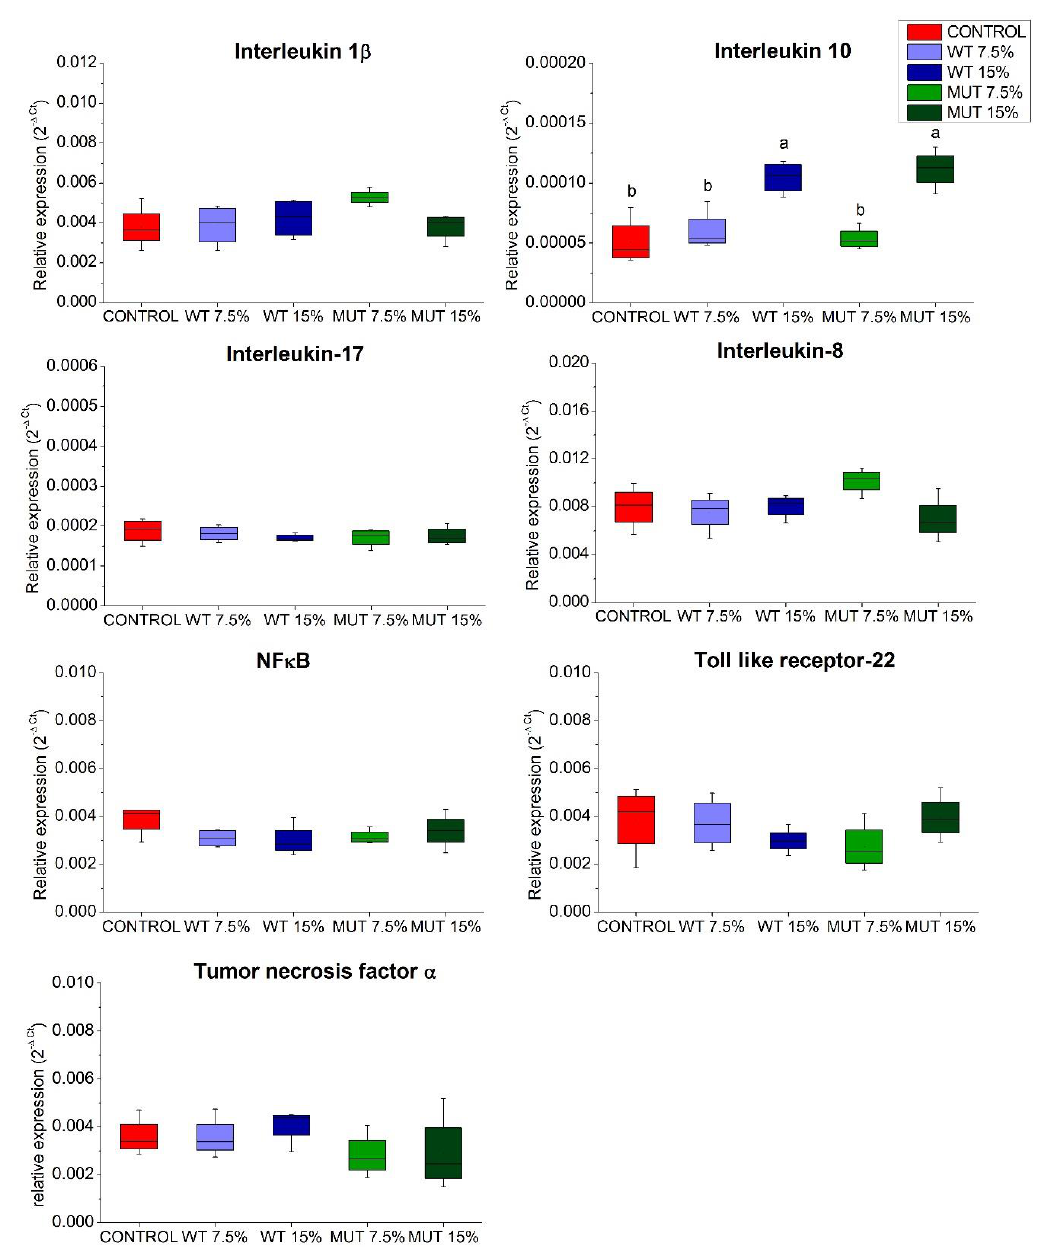
Figure 2. Expression of inflammatory cytokine genes in the gut of zebrafish fed diets supplemented with Lobosphaera incisa wild type (WT) and mutant strain (MUT). Values in box plots show relative gene-expression levels normalized to EF1α and expressed as 2 −Δ C t ( n = 4 biological replicates, each replicate is a pool of five fish). Different lowercase letters denote significant differences ( p < 0.05) between treatments.